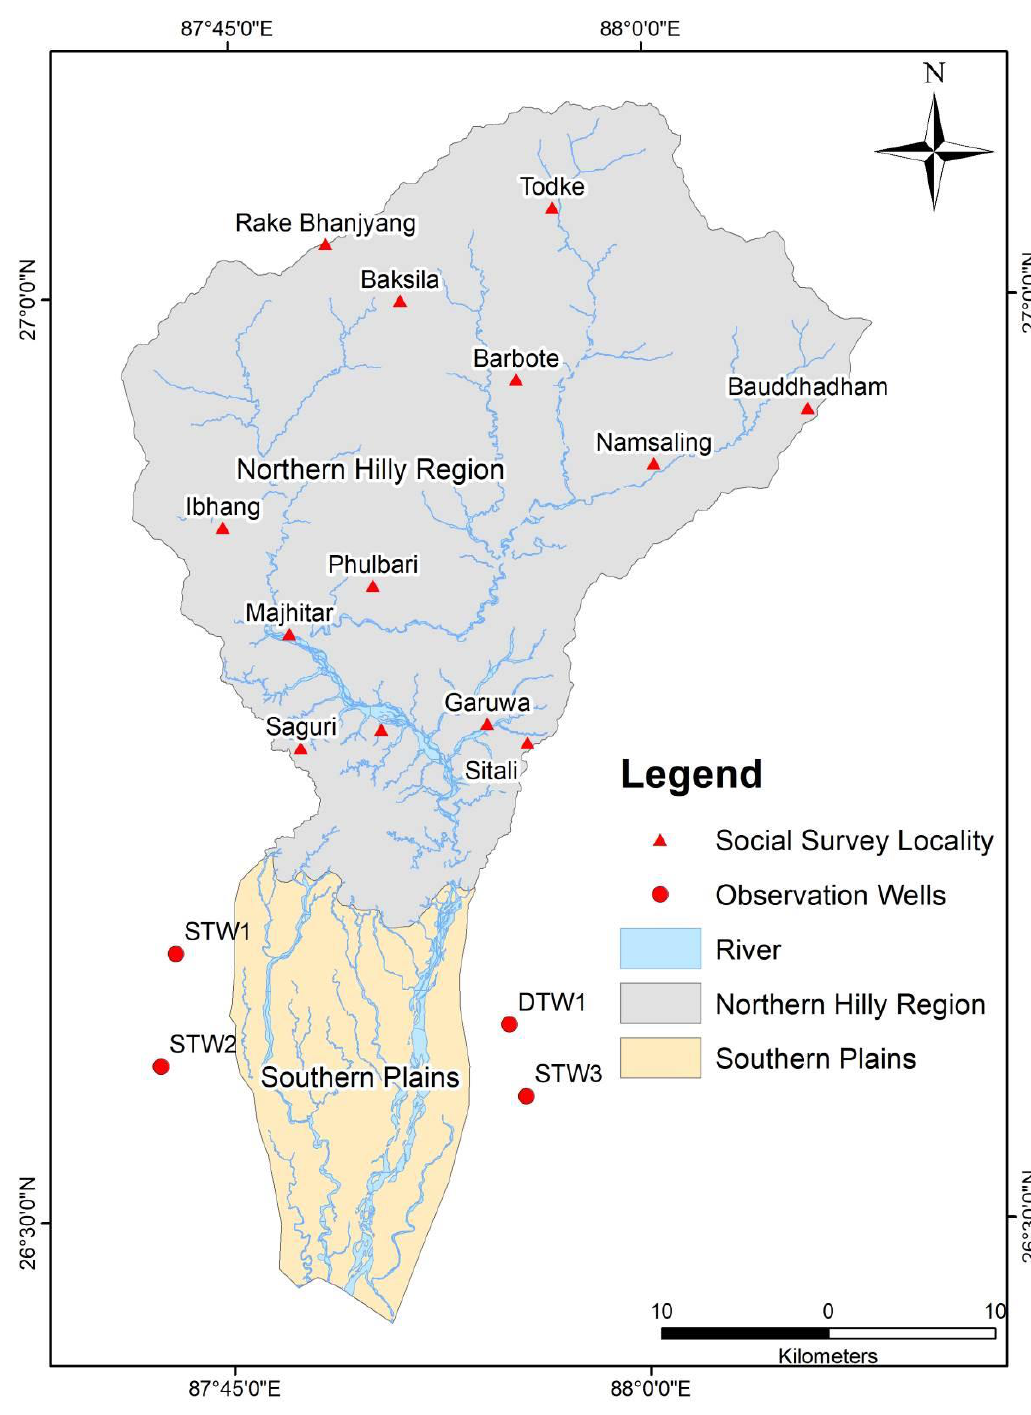
Figure 2. Map showing the distribution of localities for social survey in the northern hilly region and the observation wells (DTW: Deep tube well; STW: Shallow tube well) in the southern plains.